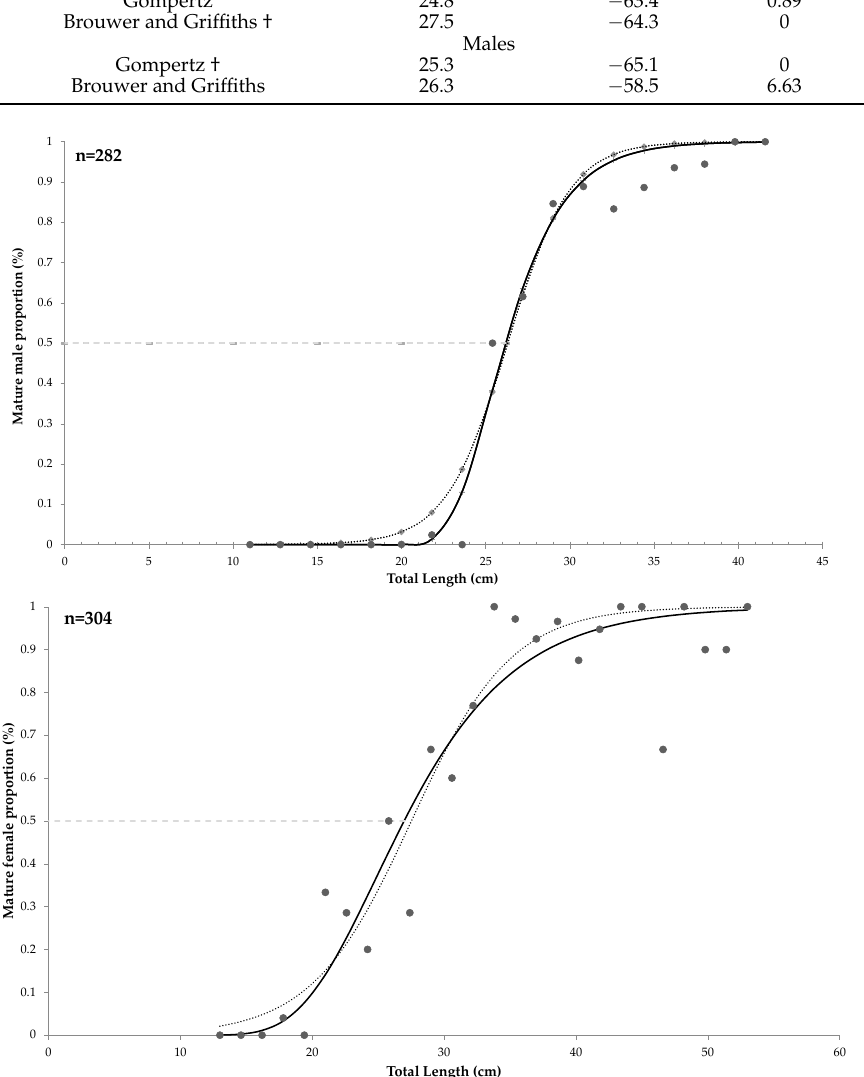
Figure 6. Maturity curves for males ( upper ) and females ( lower ) of U. chilensis in the SGC. The continuous line represents the maturity curve obtained with the Gompertz model, and the dashed line represents the maturity curve obtained with Brouwer and Gri ffi ths model.